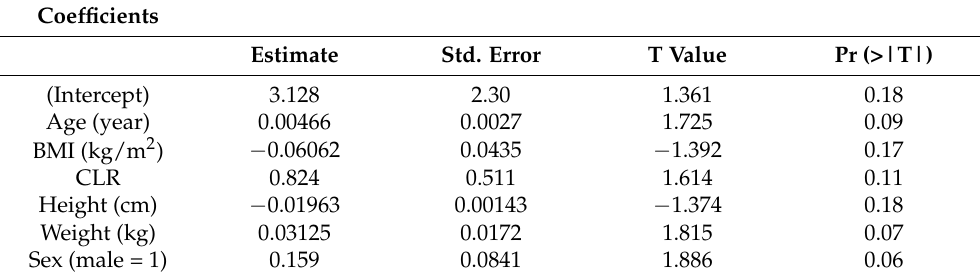
Table 3. Logistic regression of the algorithm obtained from the Hungarian patients on the L2-L4. Coefficients